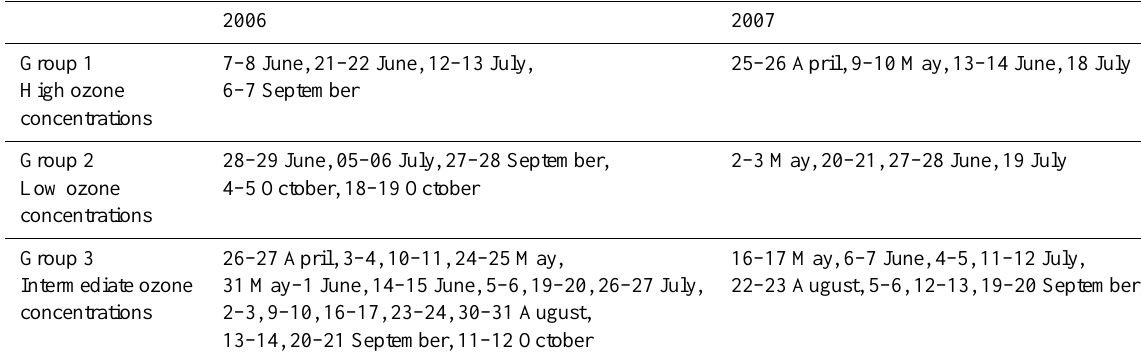
Table 2. Grouping of periods according to measured ozone concentrations (see